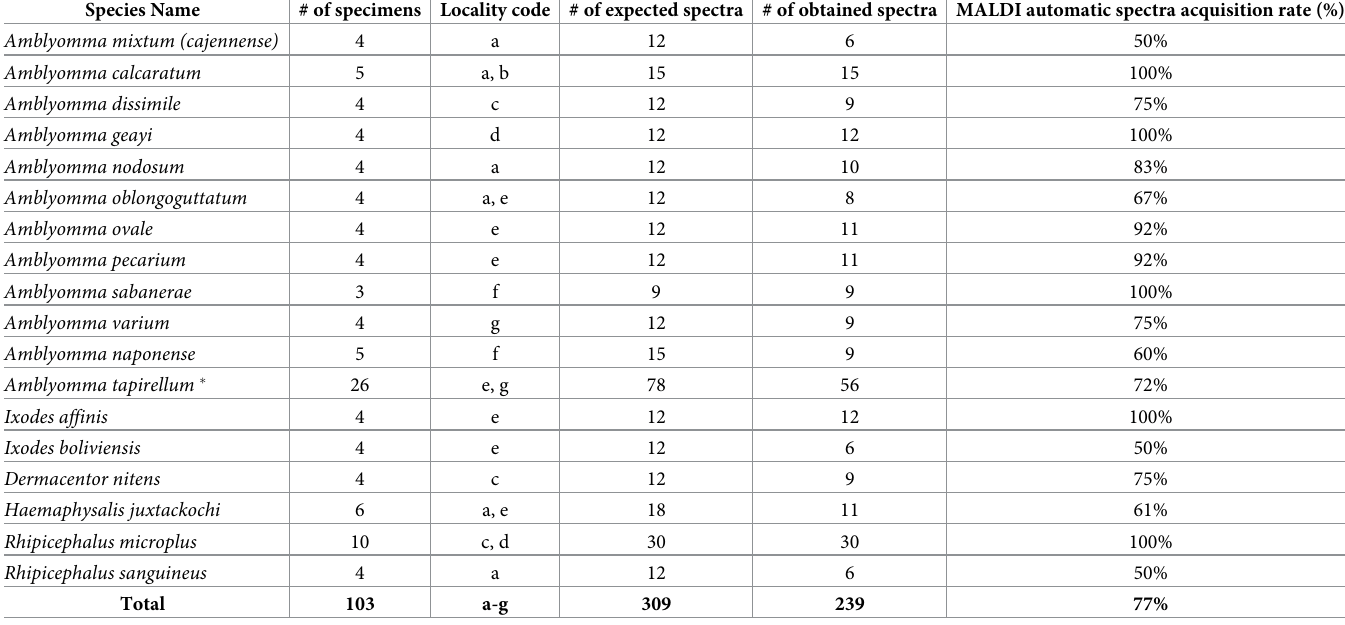
Table 1. Description of specimens subjected to analysis with the MALDI mass spectrometry